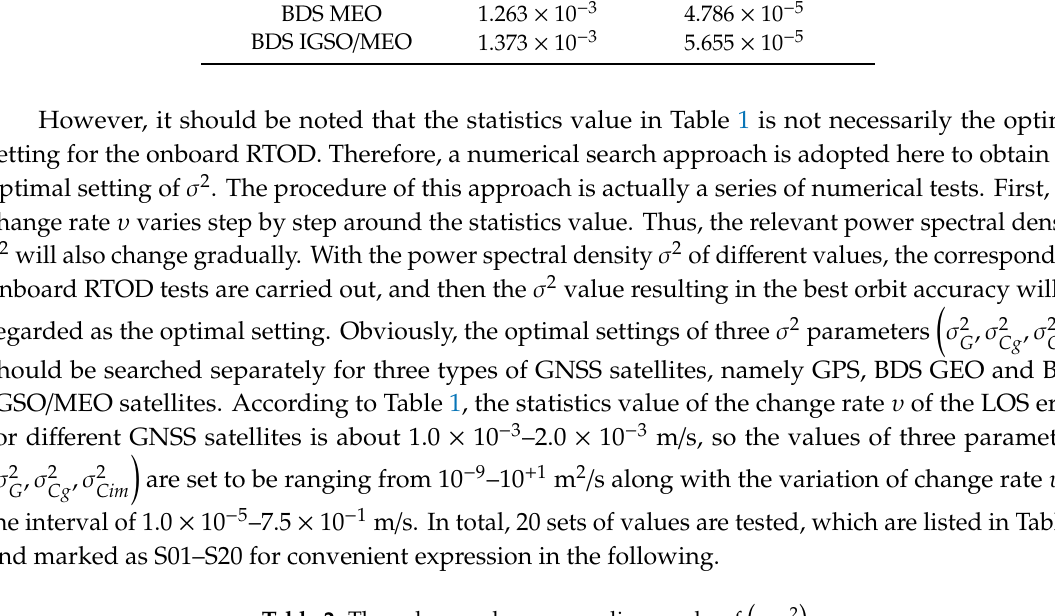
Table 2. The values and corresponding marks of